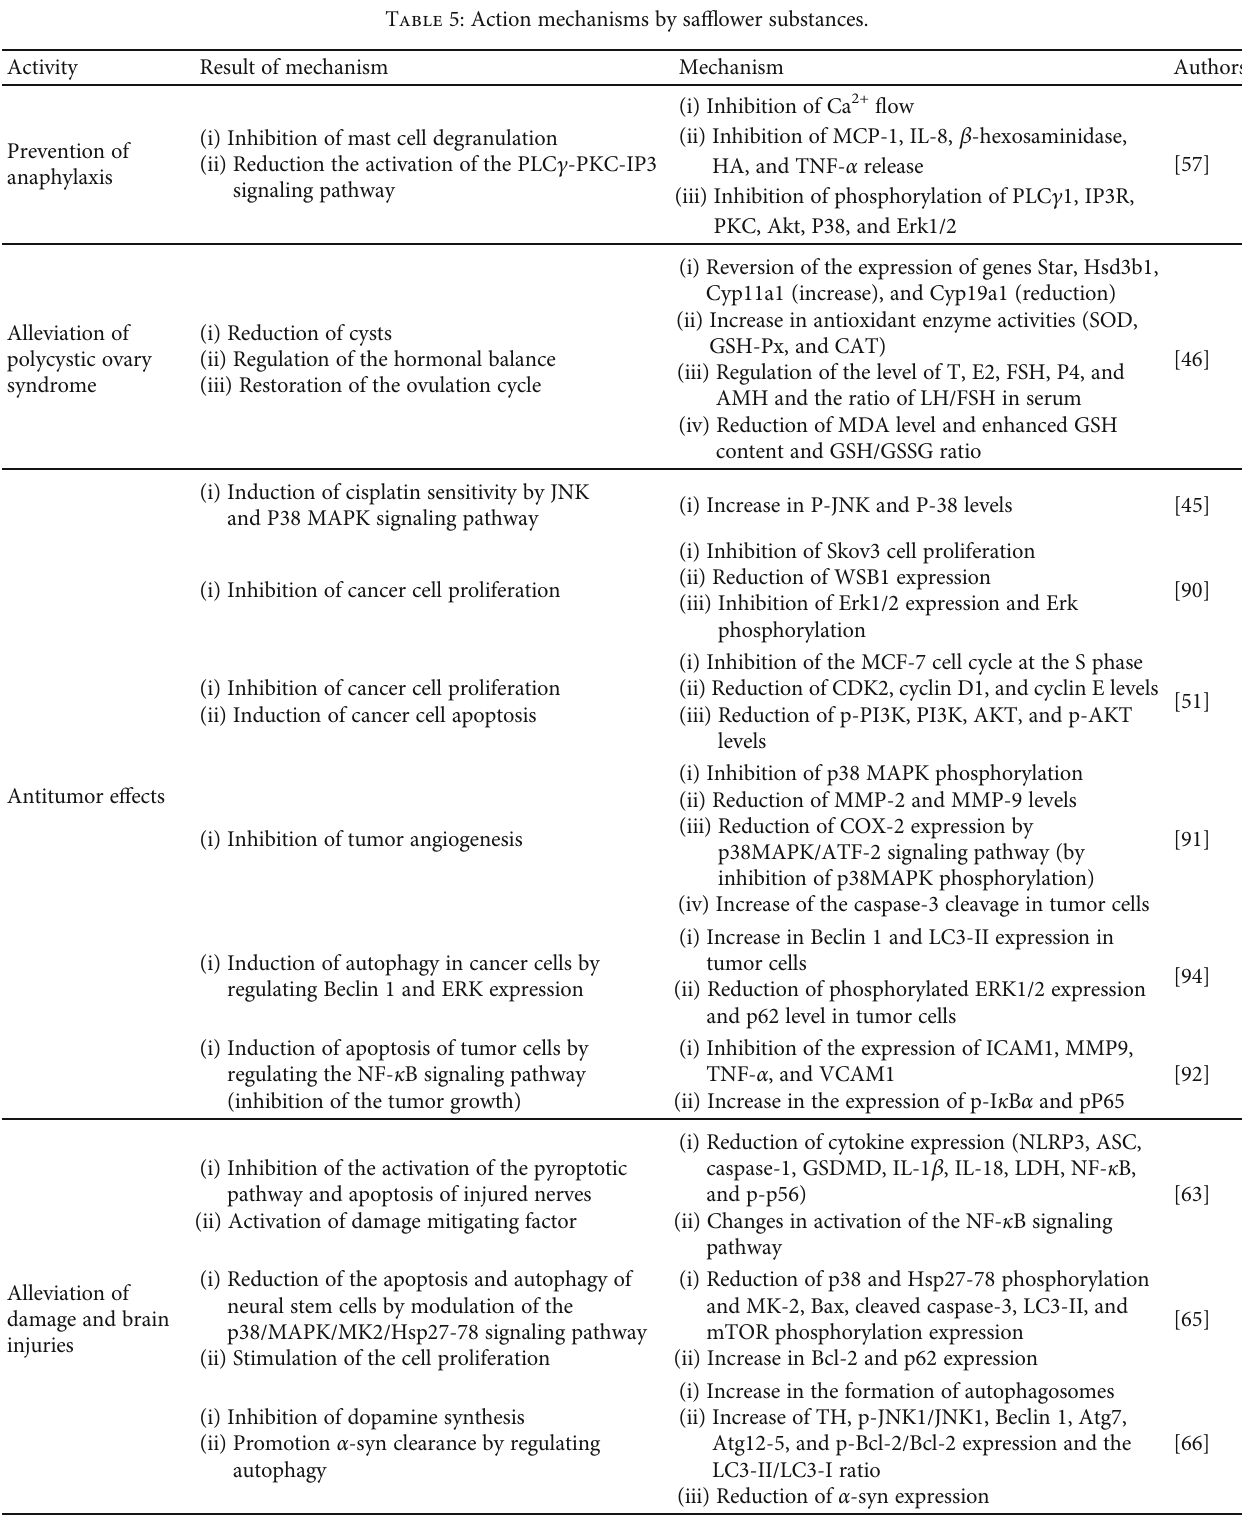
Table 5: Action mechanisms by sa ffl ower